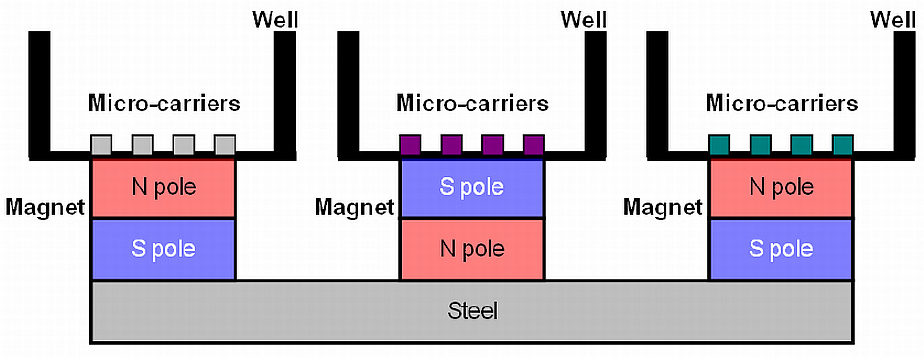
Figure 3. Schematic illustration of the magnetic circuit